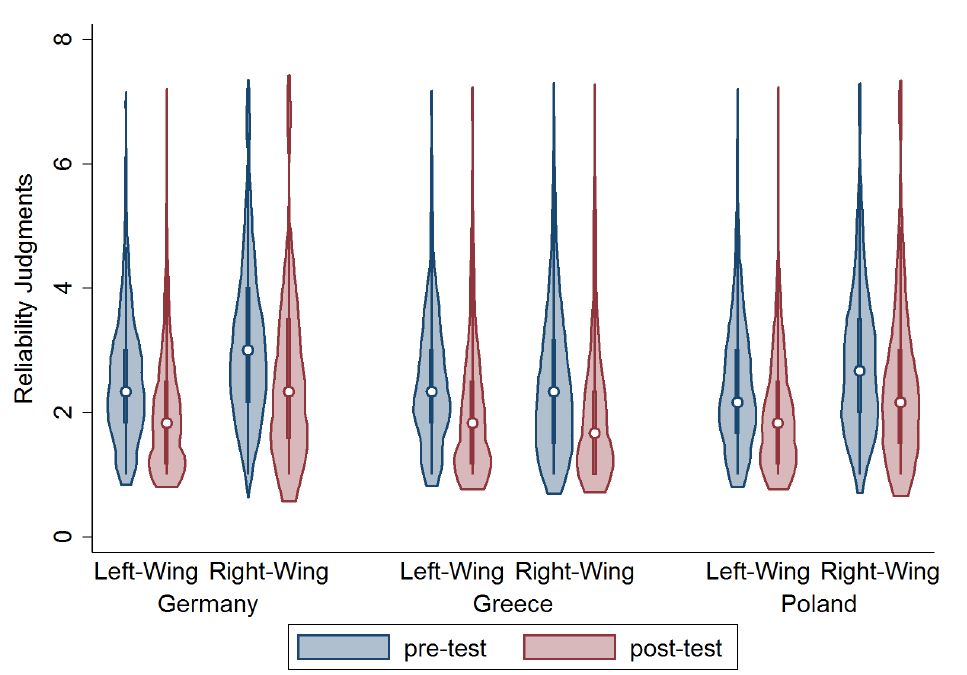
Figure 5. Violin plots for the German, Greek, and Polish versions of the game (pre-and-post-test), by political ideology (combines “very” and “somewhat” categories). The violin shape represents the distribution of the data and the point estimate is the median (with boxplot). All pre-post differences within each country (by ideology) are statistically significant at the p < 0.001